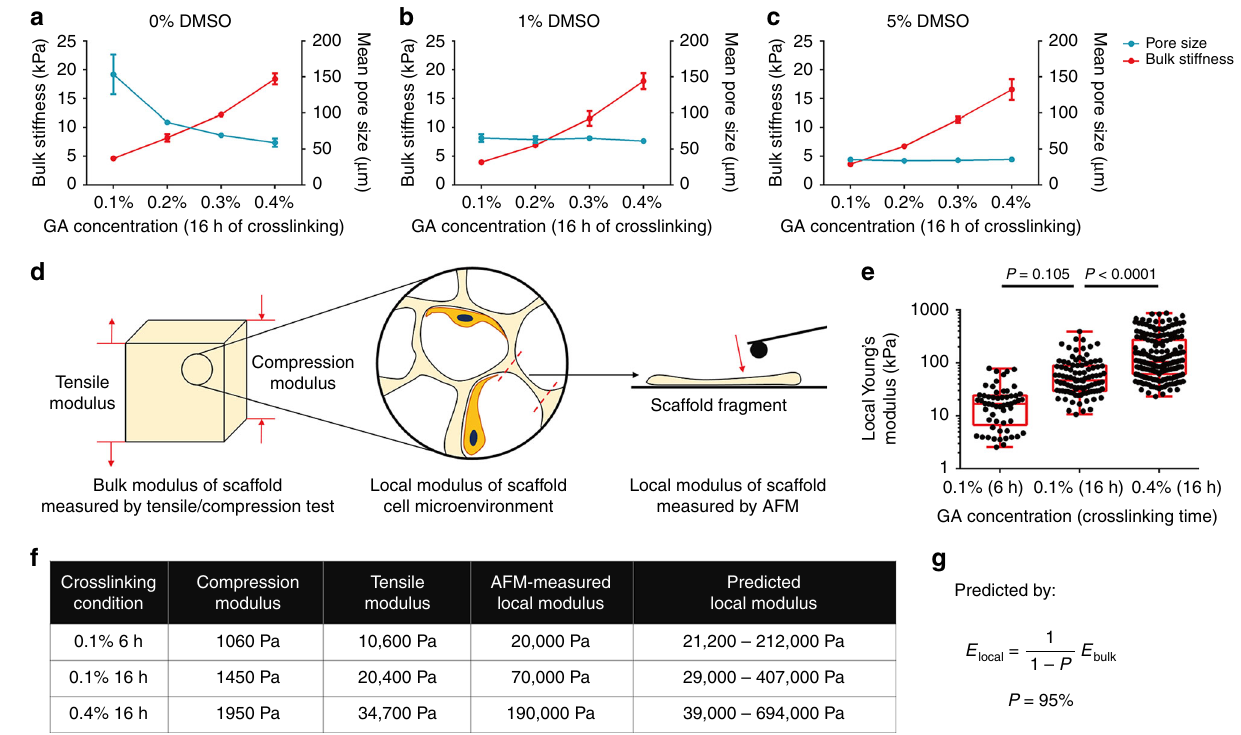
Fig. 2 Independent control of scaffold stiffness and pore size. a Traditional stiffness control using varied concentrations of chemical cross-linker (GA) caused a change in scaffold pore size (stiffness, n = 3; pore size, n = 5). b , c With the introduction of 1% or 5% DMSO, the pore size remained unchanged at 30 μ m or 60 μ m, respectively, regardless of GA concentration (stiffness, n = 3; pore size, n = 5). Data are means ± s.d. d Schematic of the methods used to characterize the mechanical properties of porous scaffolds, including the bulk stiffness by the compressive/tensile test and the local stiffness by the AFM test of scaffold fragments. e Box and whisker plot of results from AFM test revealed a 10 times difference in local scaffold stiffness from the varied cross-linking conditions. (center line, median; box limits, upper and lower quartiles, whiskers, 1.5 × interquartile range) ( n ≥ 57, ANOVA). f Correlation between the bulk scaffold compressive/tensile modulus and the local scaffold modulus measured by AFM and predicted by the theoretical model. g Theoretical model for local modulus